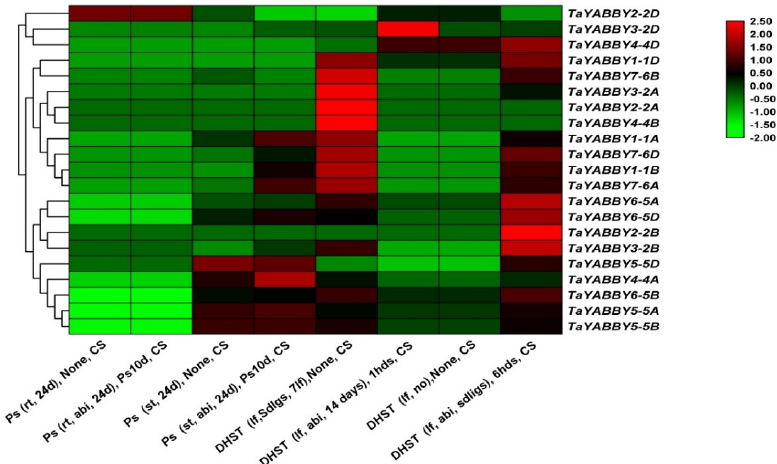
Figure 9. Heatmap of expression profiles for TaYABBY-genes under abiotic stresses. The color scale above represents expression values. Green and Red indicated the expression values increased and decreased, respectively, black indicated the expression was unregulated.PS (Phosphate starvation in Roots and shoots), DHST (Drought and heat stress time-course in Seedlings). Further detail given in Supplementary sheet 4.